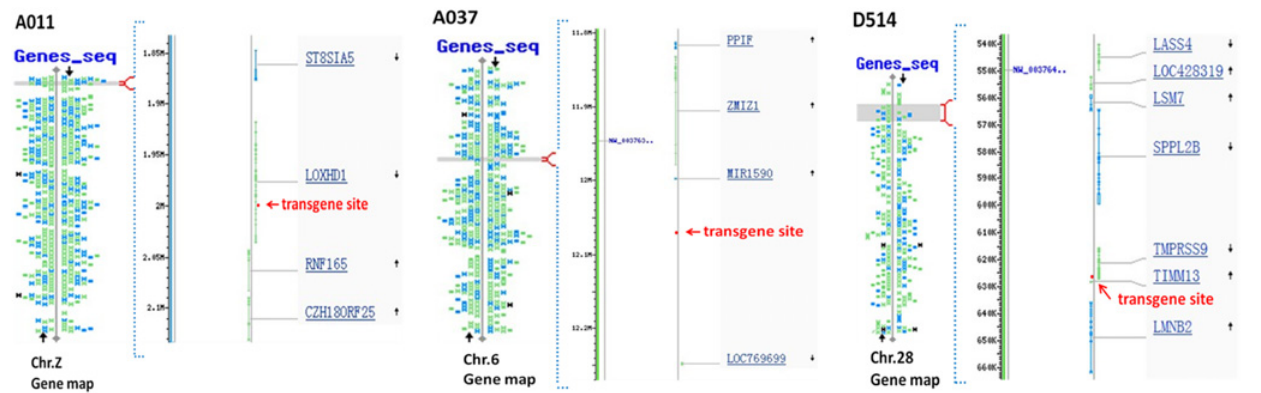
Fig 5. The identification of genomic integration sites in G 1 transgenic birds by genome walking. The alignment of sequences produced by genome walking was analysed using the BLAST database of assembled genomes (http://www.ncbi.nlm.nih.gov/) and mapped on the chicken genome.